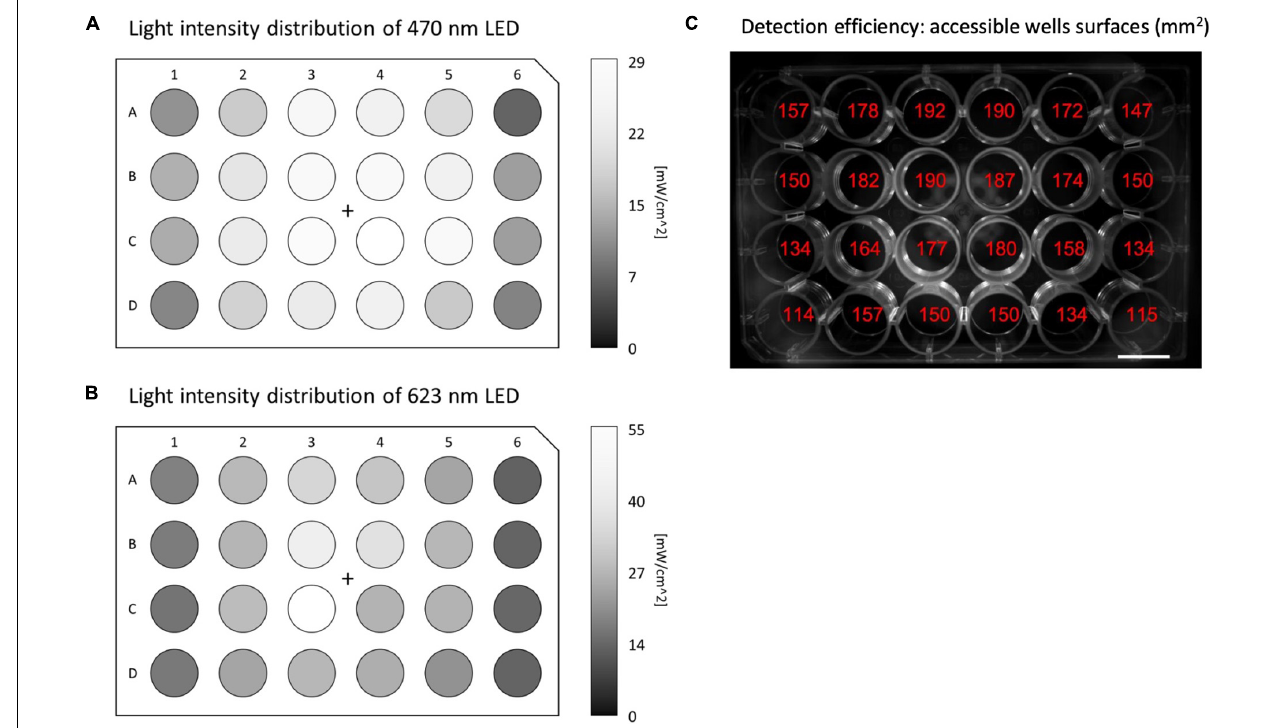
FIGURE 2 | Illumination and detection performances of MULTIPLE. Light intensity distribution across the whole 24-well plate for (A) blue and (B) red LED light, respectively, using maximum LED power. The intensity of both LEDs radially decreases moving away from the optical axis causing a more than 50% reduction for the outermost wells. (C) Image of the 24-well plate reporting for each well the accessible area exploitable for ROI measurements. Detection losses registered at the peripheral wells are introduced by the non-telecentric camera adopted in the optical